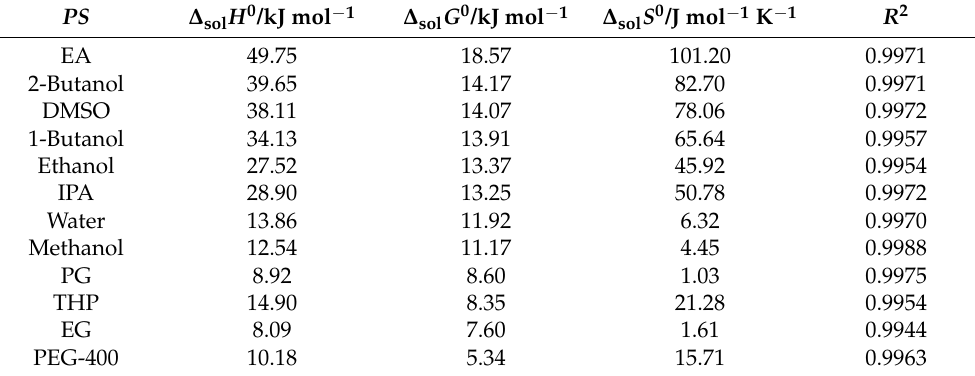
Table 8. Apparent thermodynamic parameters ( ∆ sol H 0 , ∆ sol G 0 and ∆ sol S 0 ) along with R 2 values for ECT in various PS e